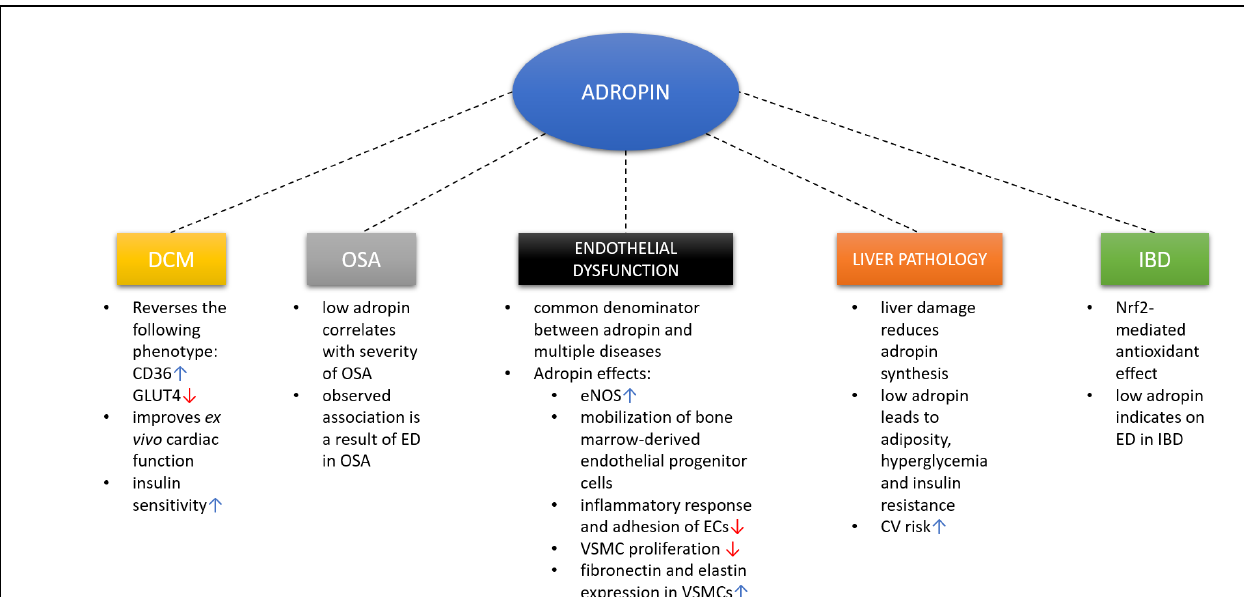
Figure 2. Association between adropin and different pathological states. Up arrow indicates upregulation, whereas down arrow indicates downregulation. Abbreviations: ED: endothelial dysfunction; eNOS: endothelial nitric oxide synthase; EC: endothelial cell; CV: cardiovascular; DCM: diabetic cardiomyopathy; OSA: obstructive sleep apnea; IBD: inflammatory bowel disease; VSMC: vascular smooth muscle cell; Nrf2: nuclear factor erythroid 2-related factor 2.